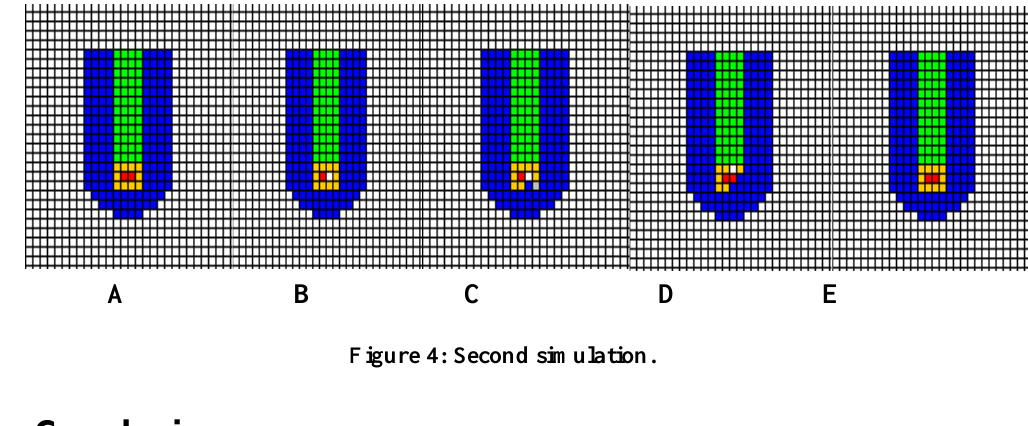
Figure 4: Second